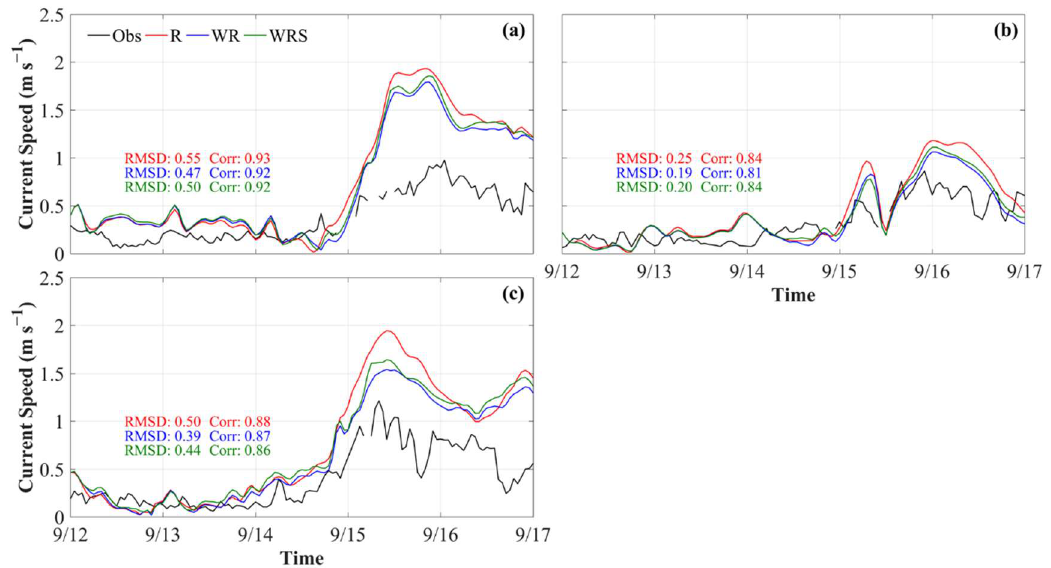
Figure 10. Spatial distribution of sea surface current (m s −1 ) from the WRS coupled experiment. Vectors show the current direction and the background color represents the current speed. Top to bottom: 00:00 14 September, 00:00 15 September and 00:00 16 September. The black line shows the TC track, the red dots are the TC positions between 12 to 17 September, with 1-day intervals, and the magenta triangles are the positions of the buoys.